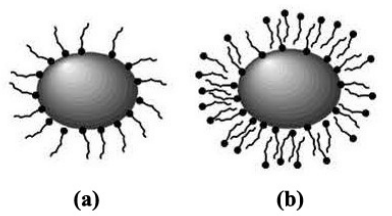
Figure 1. Single layer ( a ) Two-layer. ( b ) Coated magnetic particles.